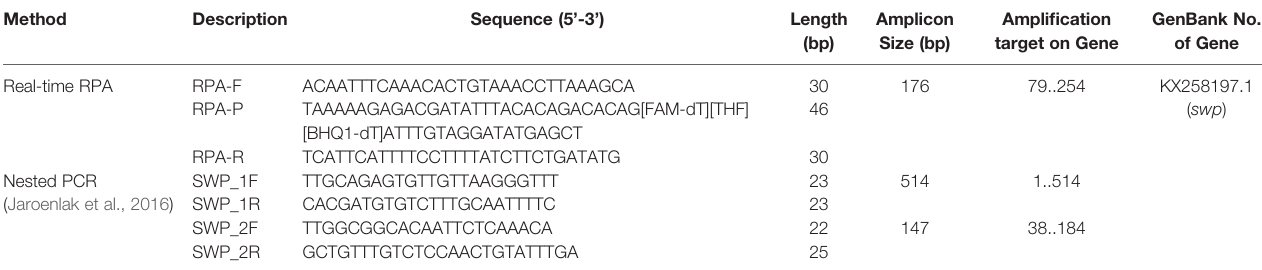
TABLE 1 | Primers and probe used in this